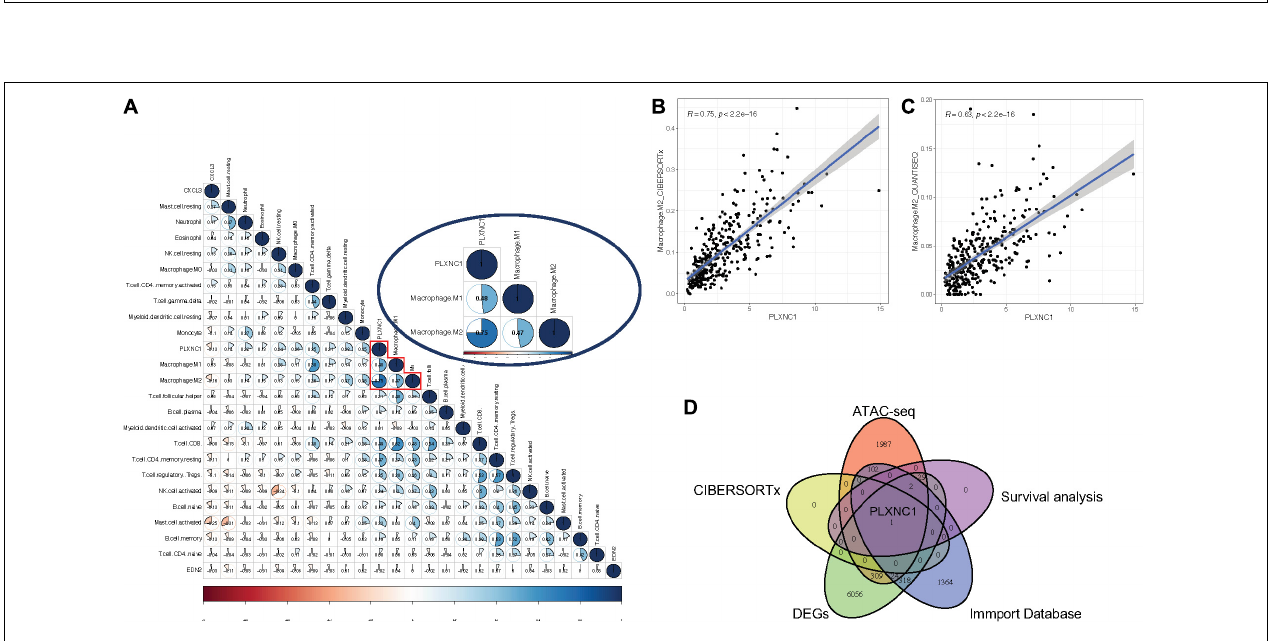
FIGURE 3 | (A) Correlation analysis between immune cells and PLXNC1 expression, which was significantly correlated with M2 macrophages [ r = 0.75 (Pearson), p < 0.01). (B) Dot plot demonstrating the correlation between macrophage cells and PLXNC1 [ r = 0.75 (Pearson), p < 0.01]. (C) QUANTISEQ algorithms confirmed the correlation between macrophages and PLXNC1 [ r = 0.63 (Pearson), p < 0.01]. (D) Schematic for co-analysis of the ImmPort database, ATAC-seq, Cox models, RNA-seq and CIBERSORTx in STAD.